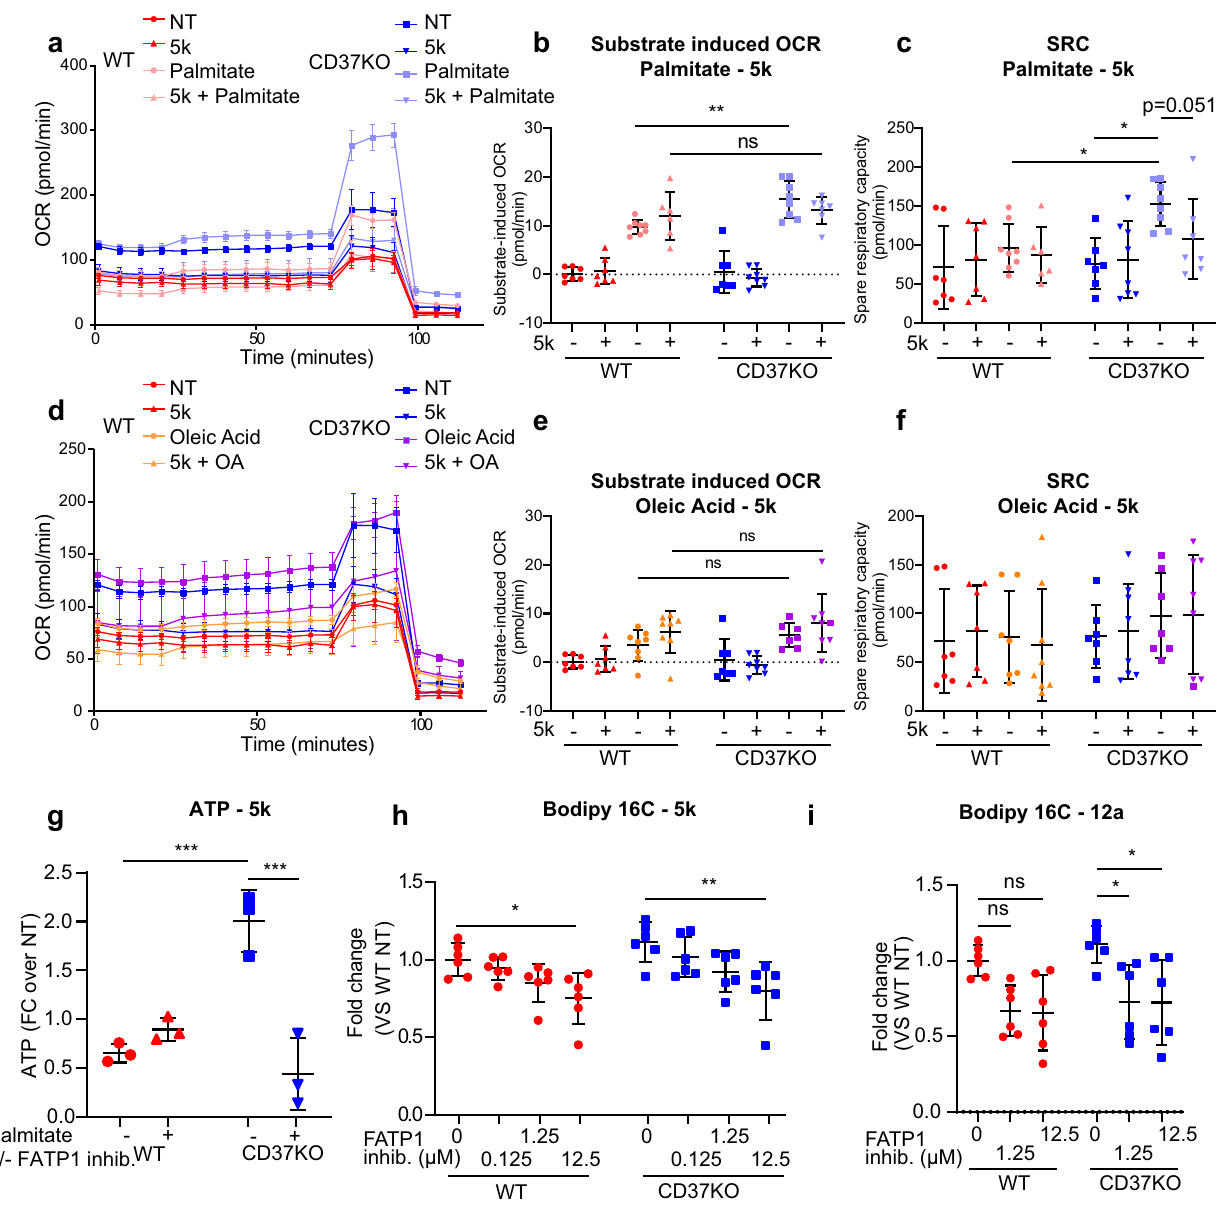
Fig.5|InhibitionoffattyacidtransporterFATP1abolishesfattyacidmetabolic switch in CD37KO B-cell lymphoma. WT and CD37KO lymphoma cells (BJAB) were incubated in a nutrient-rich medium with or without FATP1 inhibitor (com- pound 5k (12.5 µ M)) for 2h. Cells were then transferred to a nutrient-restricted medium with ( n =8) or without ( n =8) compound 5k and subjected to an acute substrate injectionof medium or palmitate (50 µ M) ( a ) or oleicacid (50 µ M) ( d ) at t =30min. Continuous oxygen consumption ratio (OCR) values are shown in response to FCCP (1 µ M) at t =70min and Rotenone/AntimycinA (Rot/AA) (1 µ M) at t =100min. Substrate-induced OCR ( b , e ) were calculated as the difference between baseline and acute substrate injection ( b : p =0.0099). The spare respiratory capacity (SRC) ( c , f ) was calculated as the difference in OCR between